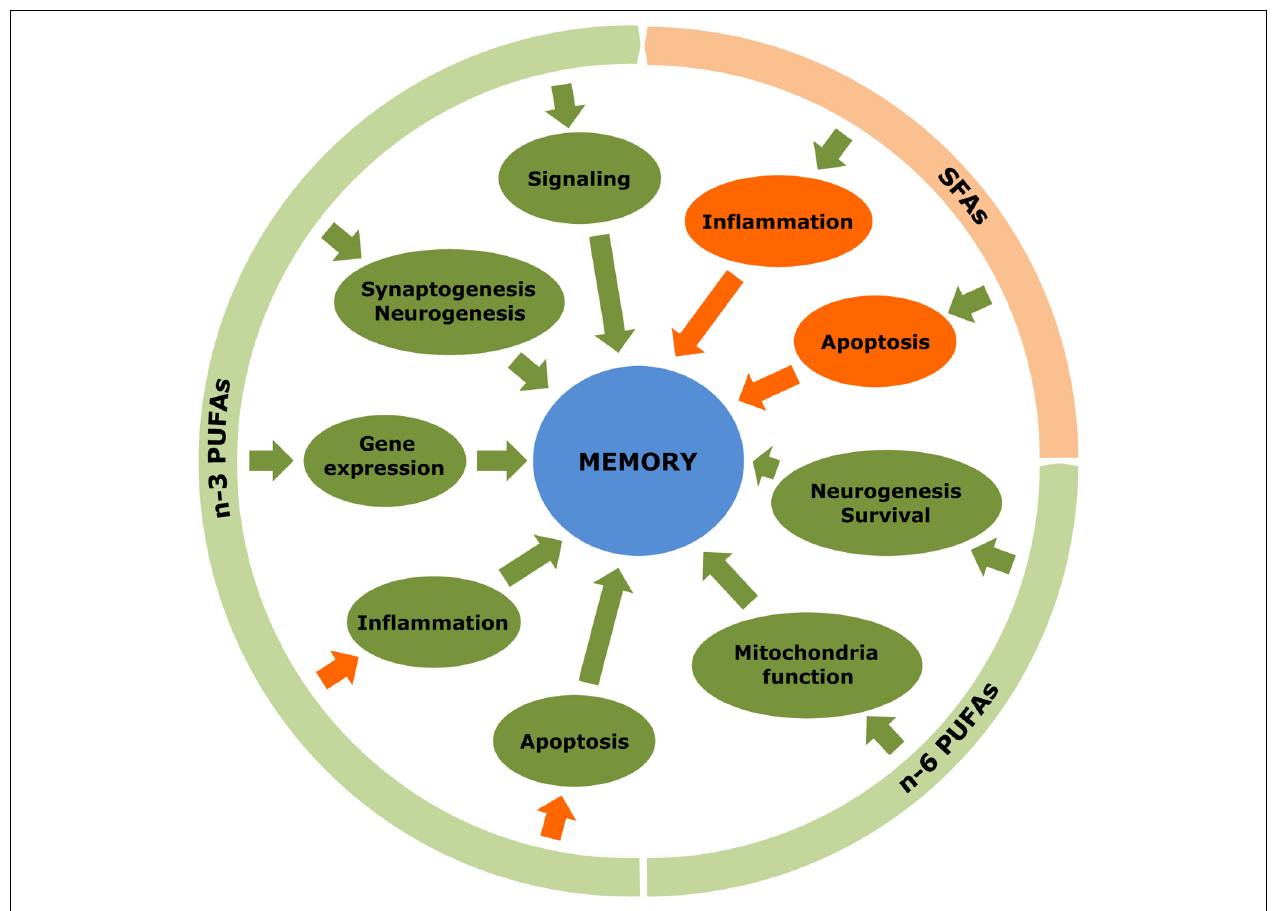
FIGURE 2 | Multiple effects of fatty acids in the hippocampus . n-3 and n-6 PUFAs exert a variety of positive actions that promote formation, storage and processing of learning and memory in the hippocampus. In contrast, SFAs display rather negative actions. Green arrows indicate stimulatory effects while orange arrows represent inhibitory